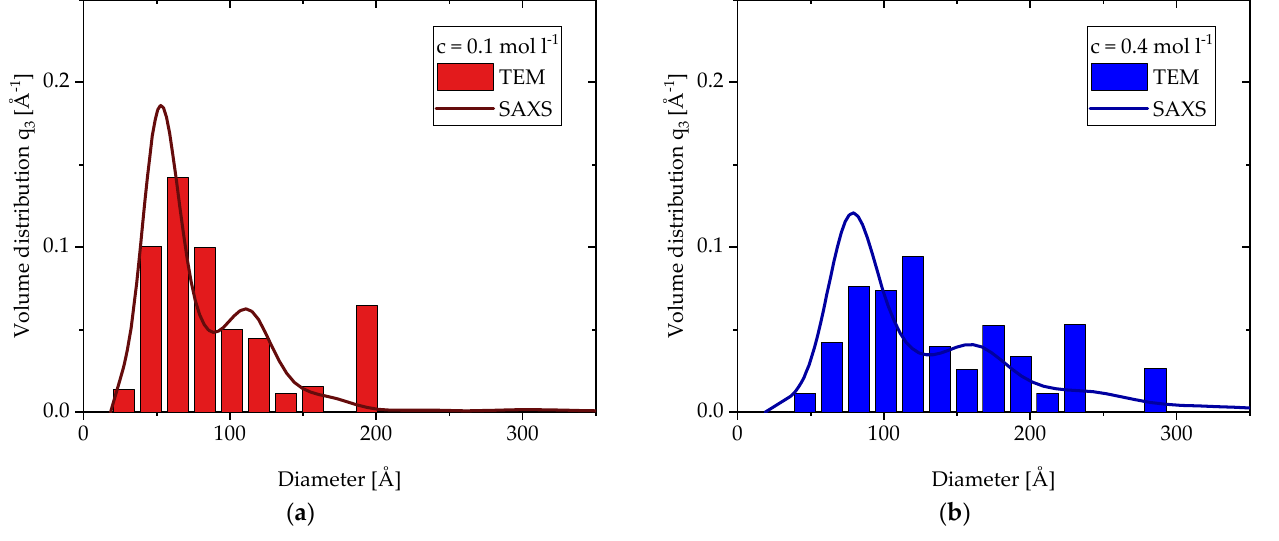
Figure 6. Volume size distribution with numbered peak calculated from SAXS data of primary par- ticles made by SFS with three different precursor concentrations.